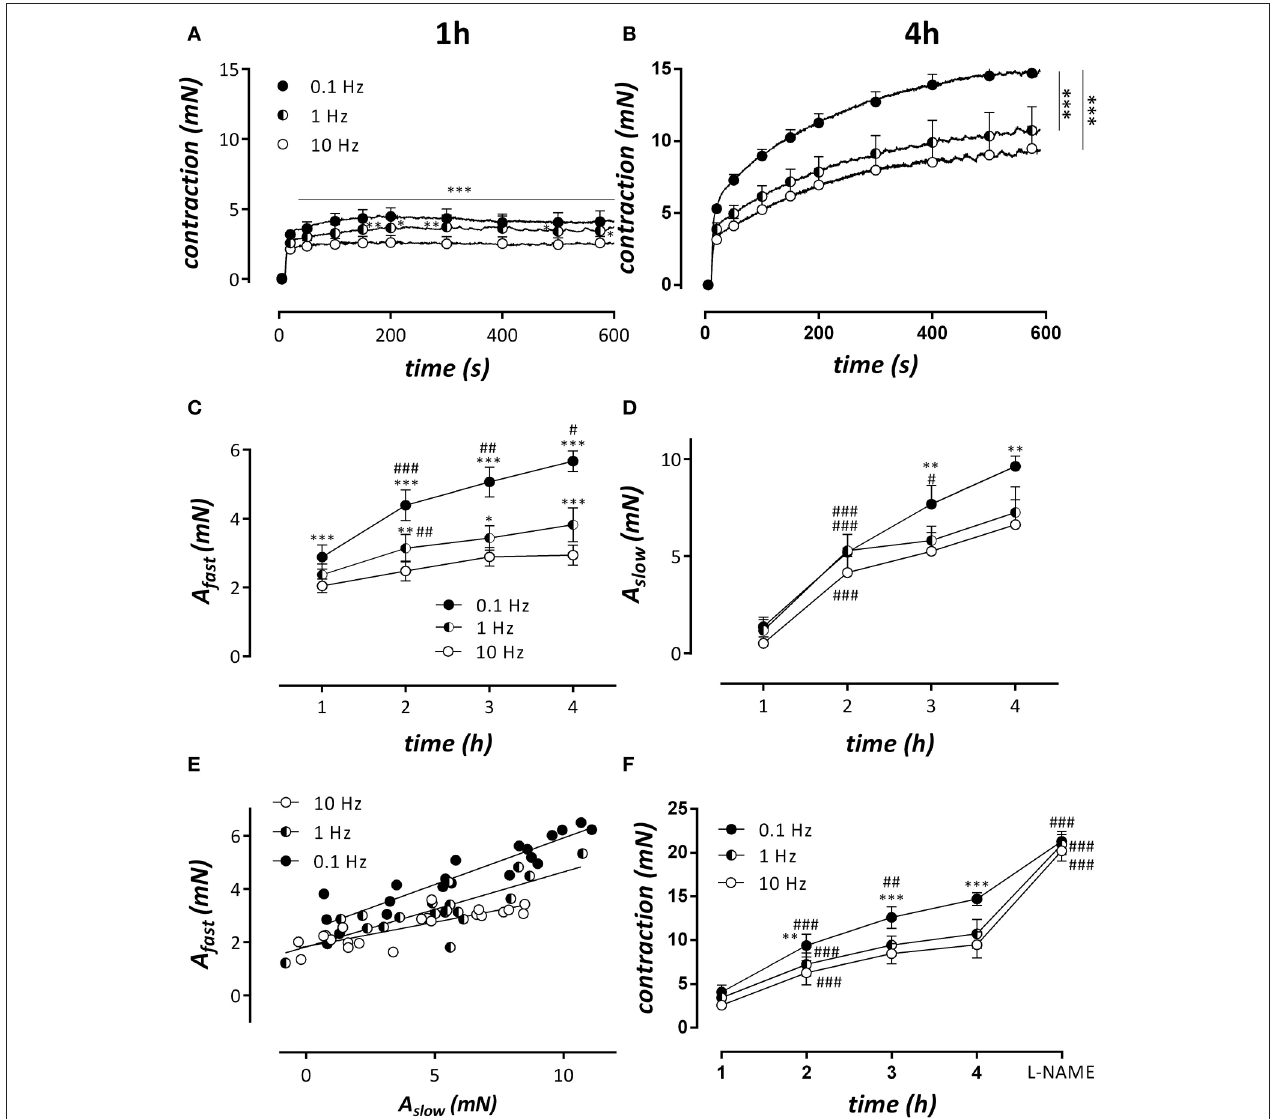
FIGURE 9 | Cyclic stretch between 80 and 120mm Hg was applied for 1, 2, 3, and 4h at stretch frequencies of 0.1, 1, and 10Hz after which the isometric contractions by 2 µ M PE were measured at 80mm Hg. After the isometric contraction at 4h, 300 µ M L-NAME was added to block basal NO release. (A,B) Show isometric contractions by PE at the different frequencies at 1h (A) and 4h (B) after mounting. Traces at 1, 2, 3, and 4h were analyzed with a double exponential function revealing amplitudes of fast (A fast , C ) and slow (A slow ) force components as a function of time after mounting. (E) Shows the relationship between fast and slow component at the different frequencies. All slopes were significantly different from zero and significantly different from each other ( p < 0.001, pearson correlation). In (F) , the “steady-state” contraction after 600s in the different conditions is shown. * P < 0.05, ** P < 0.01, *** P < 0.001 vs. 10Hz in (A–F) ; # P < 0.05, ## P < 0.01, ### P < 0.001 vs. previous time point. n = 5–6, two-way ANOVA with Tukey’s multiple comparison test.